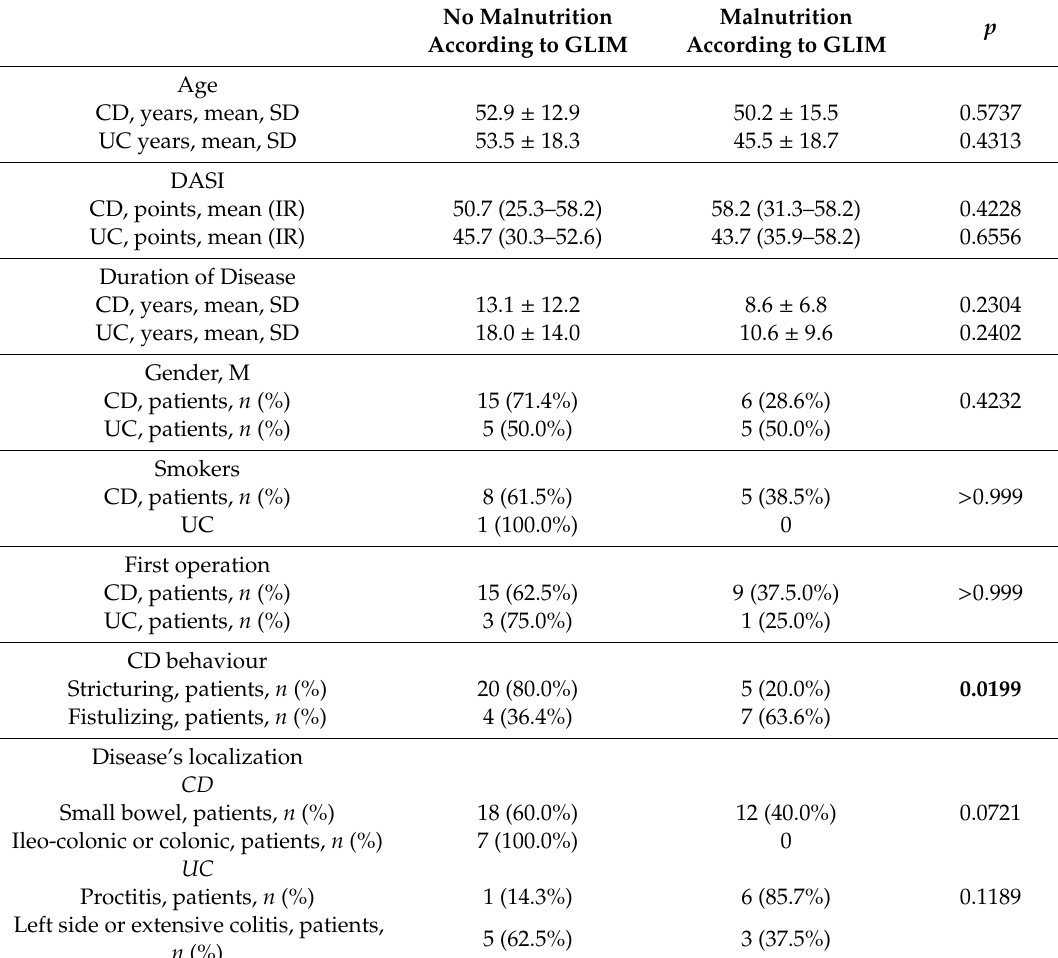
Table 4. Analysis of continuous and categorical variables in relation to the onset of malnutrition.